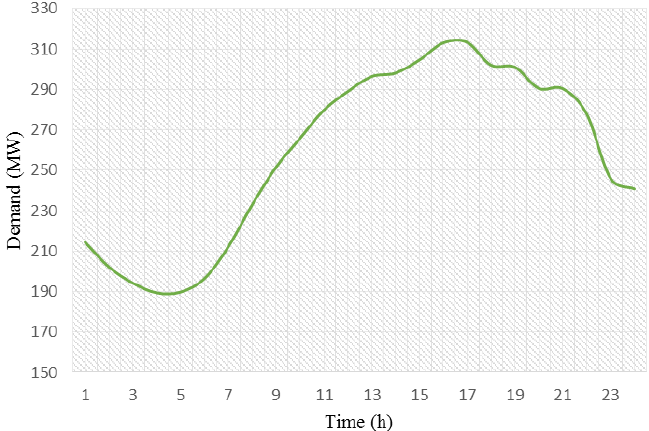
Figure 2. Predicted hourly load of the 6-bus system.